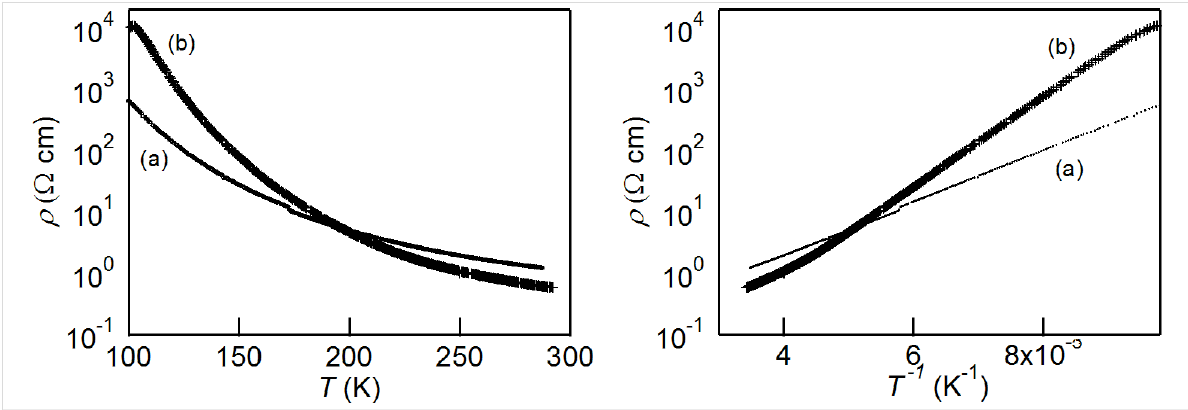
Figure 4: Temperature dependences of electrical resistivities for (a) achiral charge transfer salt θ 21 -[( S,S )- 2 ] 3 [( R,R )- 2 ] 3 (ClO 4 ) 2 and (b) chiral salt α '-[( R,R )- 2 ] 2 ClO 4 (H 2 O).